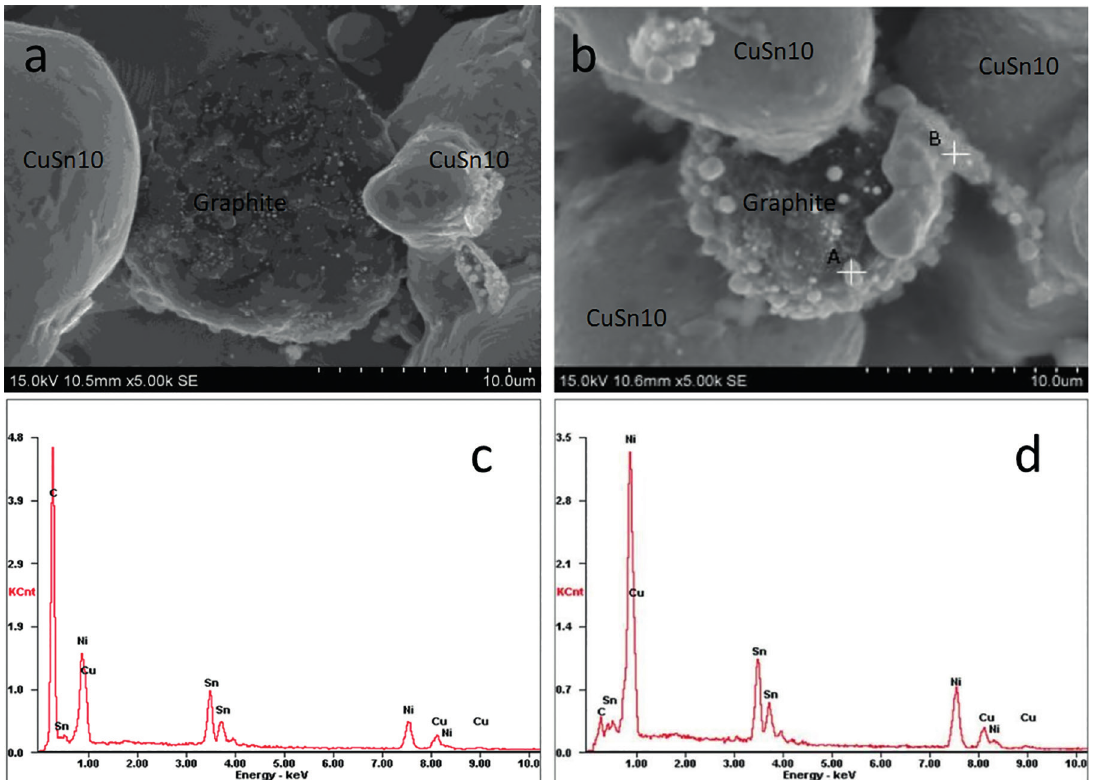
) and PVA solution treated by primary sintering, (b) 3 2